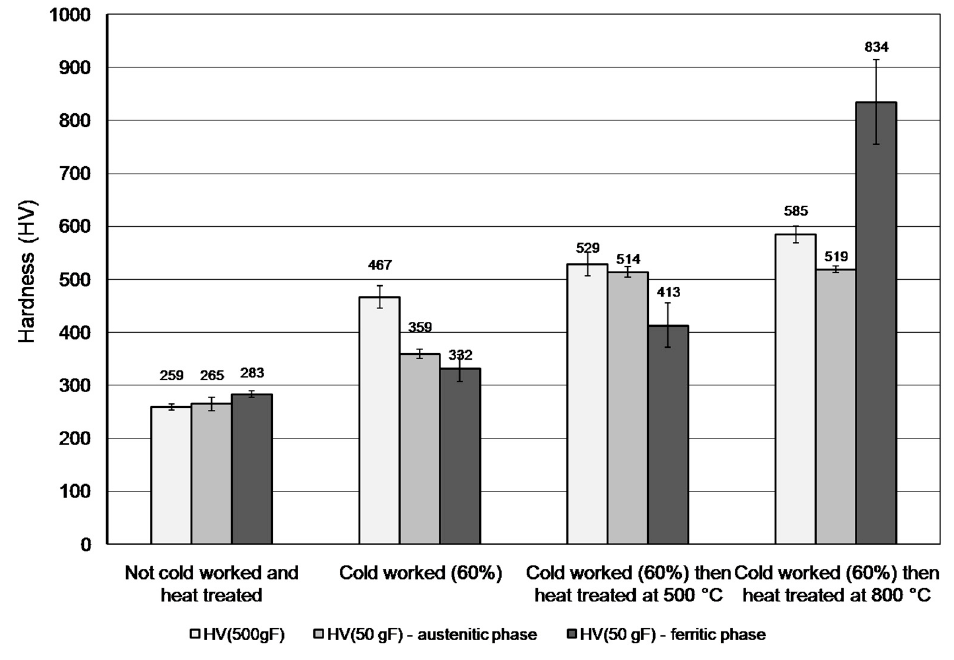
Figure 5. Results of hardness tests.